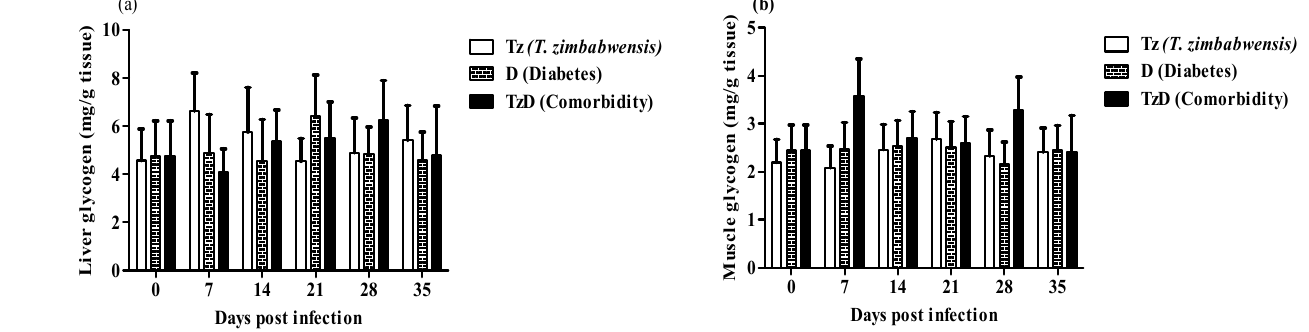
Figure 3. Insulin concentration in groups of male Sprague Dawley rats that were; comorbid with type 2 diabetes mellitus (TzD), diabetic (D) and infected with Trichinella zimbabwensis (Tz). Values are presented as mean ± SEM ( n = 6 for each group).